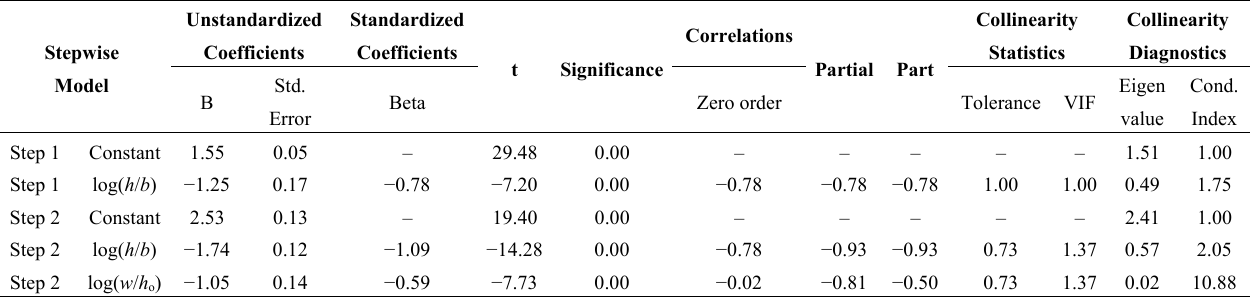
Table 9. The regression statistics of stepwise